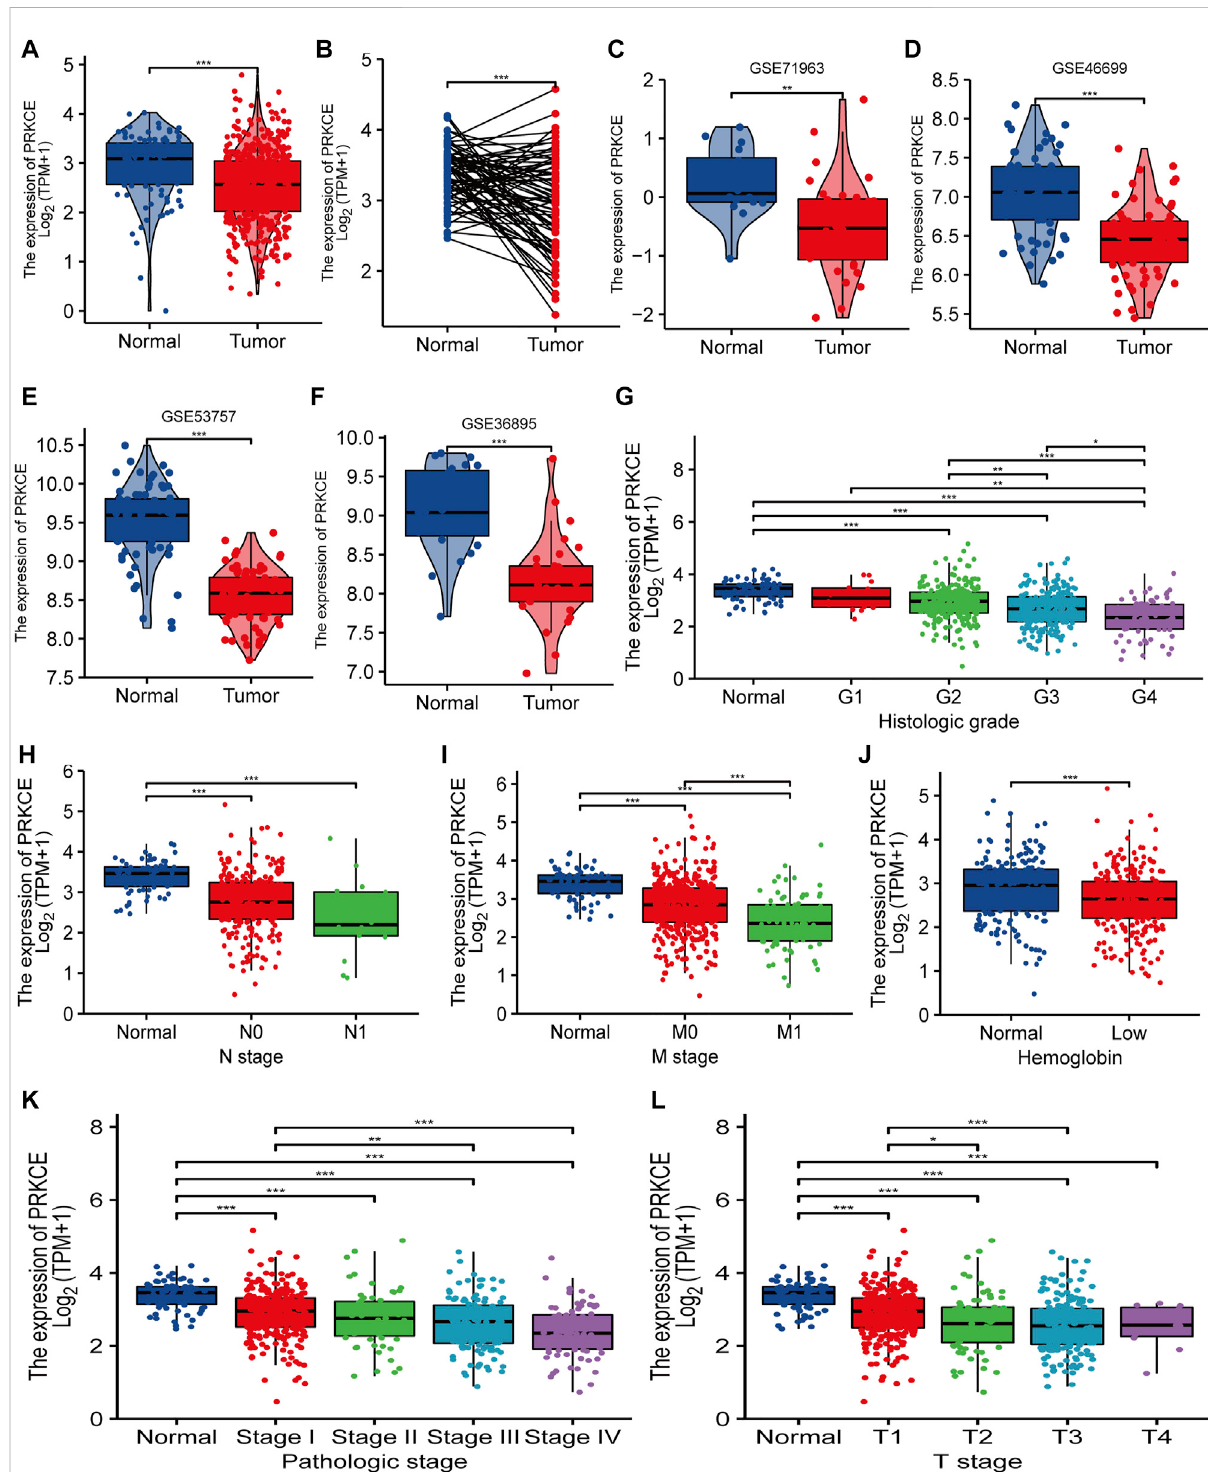
FIGURE 1 Decreased PRKCE expression correlates with cancer risk factors and aggressiveness in KIRC patients. (A – F) The expression levels of PRKCE in KIRC. (G – L) AssociationbetweenPRKCEexpressionandclinicopathologicalcharacteristicsincluding (G) histologicgrade, (H) Nstage, (I) Mstage, (J) Hemoglobin level, (K) Pathologic stage, (L) T stage. * p < 0.05, ** p < 0.01, *** p < 0.001. KIRC, Kidney Renal Clear Cell